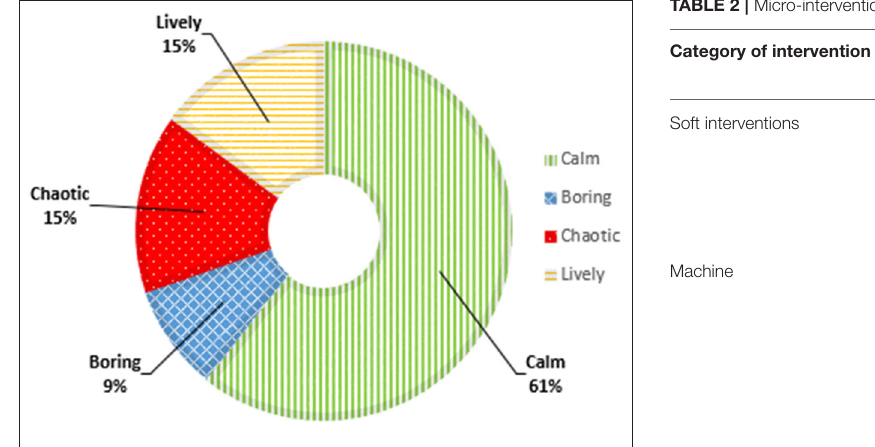
FIGURE 5 | Soundscape dimensions pre-implementation of micro-interventions.